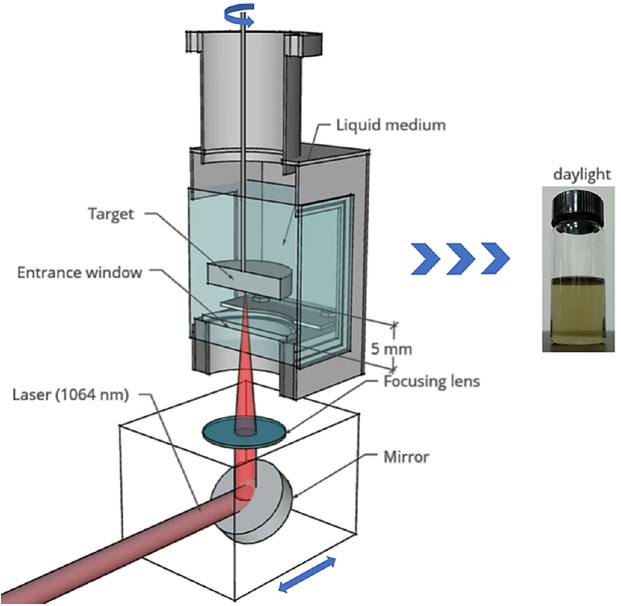
Figure 1. The experimental setup used for carbon nanoparticle (CNP) generation through the pulsed laser ablation in liquid (PLAL) method. The inset digital image shows the daylight appearance of the obtained CNP suspension in ethanol.